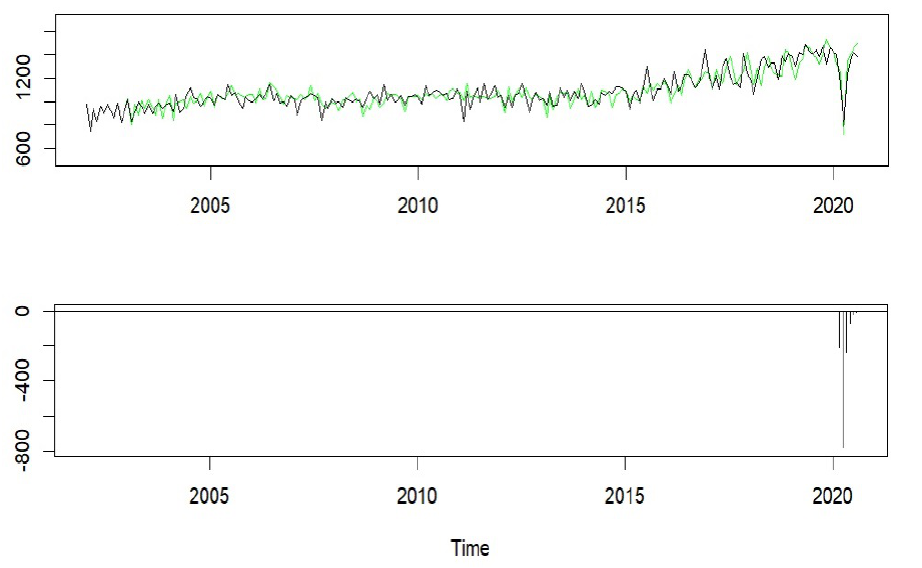
Figure 16. Female donor transplant counts with the model fit ( top ) and the estimated COVID-19 effects ( bottom